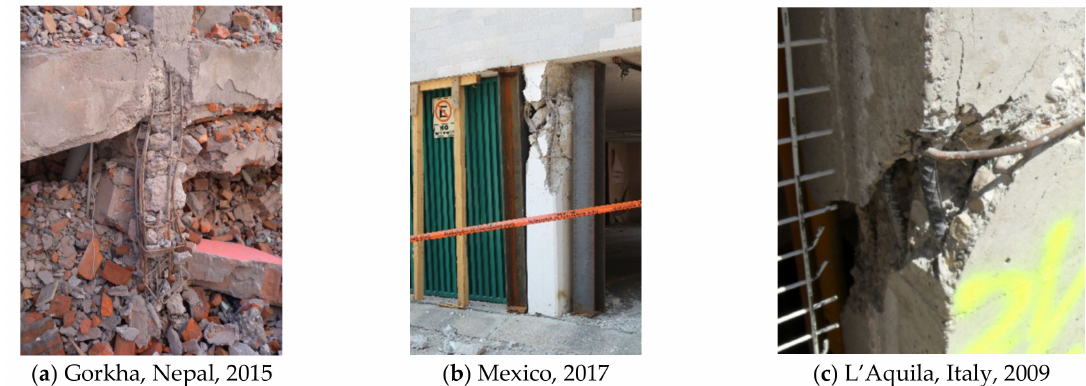
Figure 5. Damage type 2—example of post-earthquake damage in RC columns: ( a ) Bond and inadequate spacing of the bars and stirrups; ( b ) inadequate stirrup detailing and spacing; and ( c ) inadequate stirrup detailing and use of plain smooth